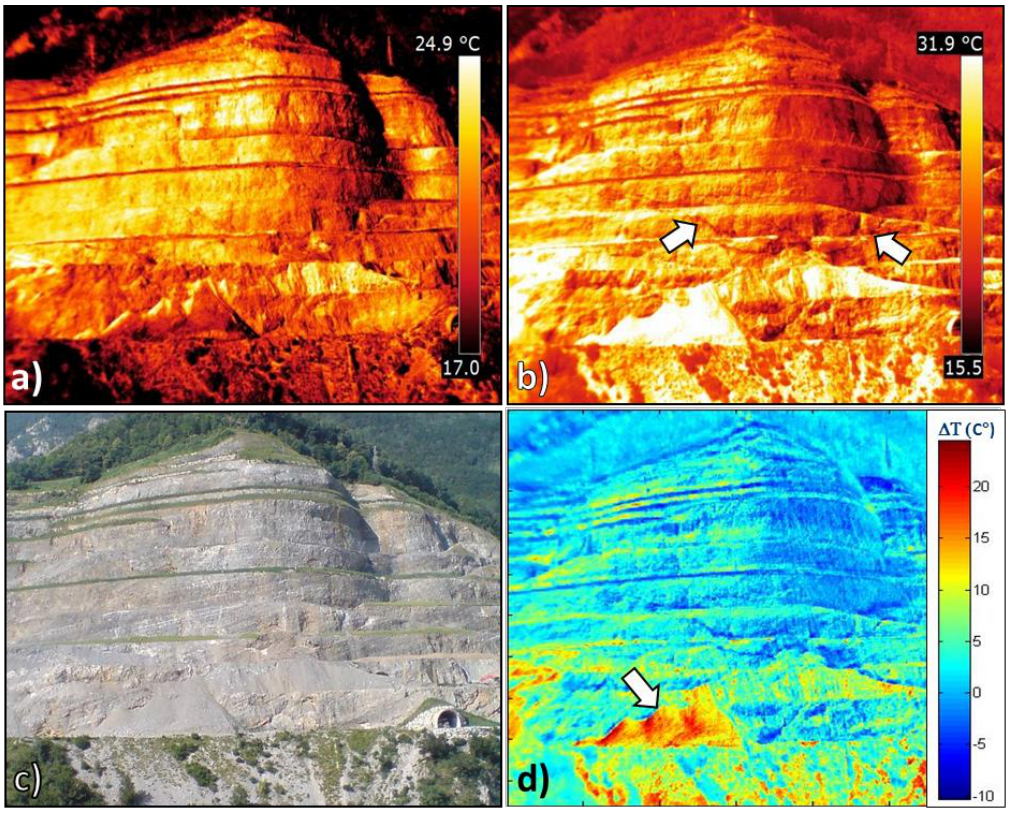
Figure 7. 2D surface temperature maps of the investigated quarry sector acquired at h 08:00 ( a ) and 13:00 ( b ) in the month of July. Optical image acquired by the built-in digital camera ( c ) and 2D differential surface temperature map ( d ) between ( a , b) .